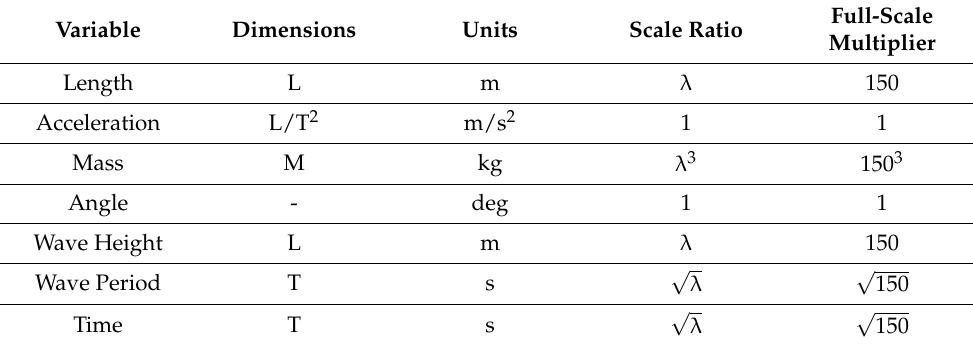
Table 1. Froude Scaling Common Ratios.